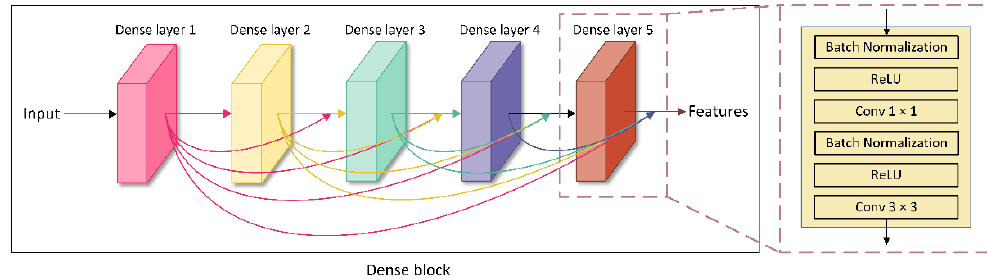
Figure 3. Dense block composed of five Dense layers.